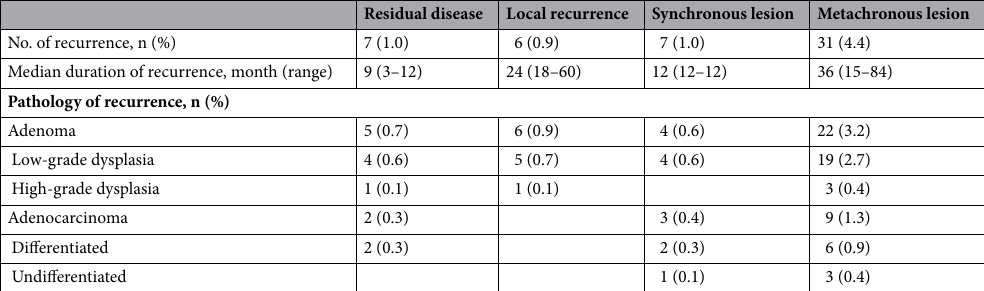
Table 2. Incidence and characteristics of recurrent tumor. Values are number of cases with percent in parentheses.